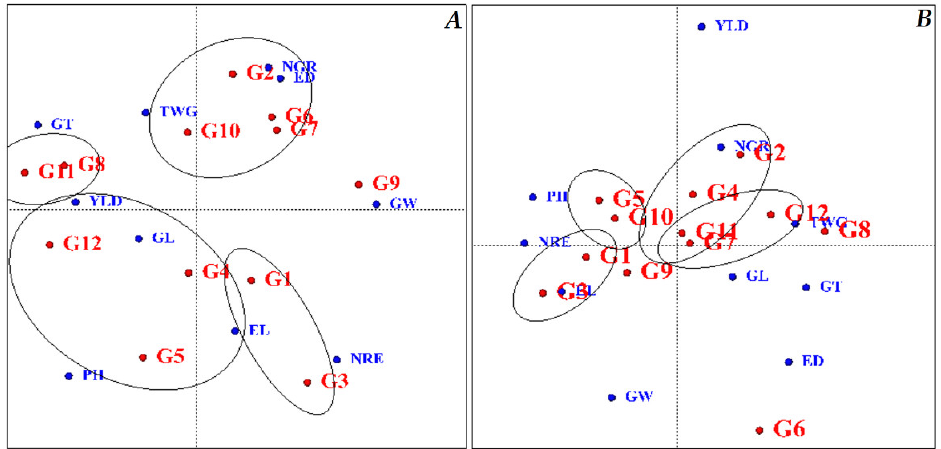
Figure 4. Graphing diagram of Maize hybrids based on the traits studied in the experiment under normal conditions and moisture stress. ( A ): normal conditions, ( B ): stress conditions. PH: Plant height, EL: Ear length, ED: Ear diameter, NGR: Number of grains in a row, NRE: Number of rows in-ear, GW: Grain weight, GL: Grain Length, GT: Grain Thick-ness, TWG: Thousand-grain weight, and YLD: Grain yield. G1: KSC703, G2: KSC260, G3: KSC705, G4: KSC400, G5: KSC706, G6: KSC704,